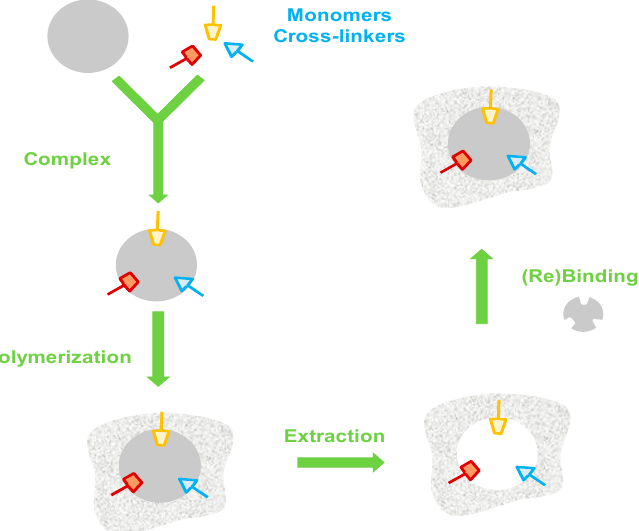
Figure 1. Synthesis of molecularly imprinted polymers.